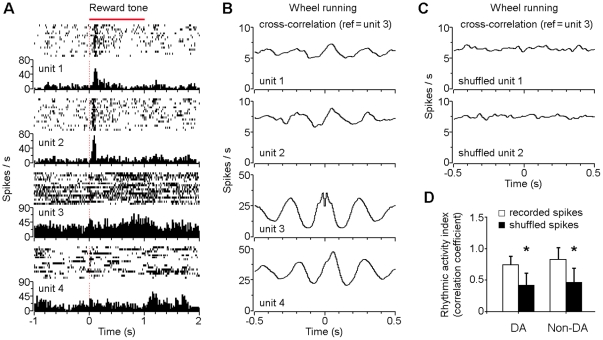
Rhythmic activity of both putative DA and non-DA neurons during wheel running.(A) Peri-event rasters and histograms of four simultaneously recorded VTA neurons in response to the conditioned tone that reliably predicted food delivery (units 1 & 2: putative DA neurons; units 3 & 4: non-DA neurons). (B) Smoothed cross-correlation histograms of the same four neurons (as shown in A) during voluntary wheel running. Unit 3 was used as the reference for cross-correlation calculations. (C) Smoothed cross-correlation histograms of shuffled units 1 and 2 (randomized spikes). The same unit 3 (as shown in B) was used as the reference for cross-correlation calculations. (D) Correlation coefficient analyses and comparisons between the recoded and shuffled spikes. A set of simulated sine oscillation curves y  =  sin (ax + b) were used as the reference for the correlation coefficient analysis (see Materials and Methods). n = 14 and 29 for DA and non-DA neurons, respectively; *P<0.001, Student's paired t-test. Error bars represent s.d.